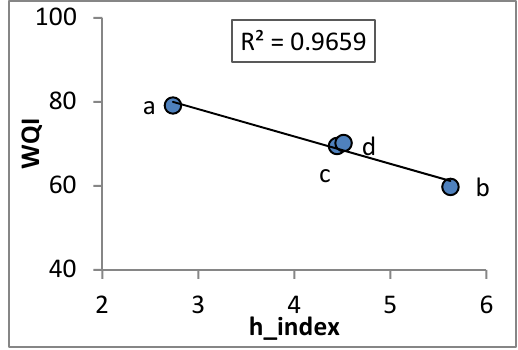
Figure 8. Comparison of hierarchy indices and water quality indices.